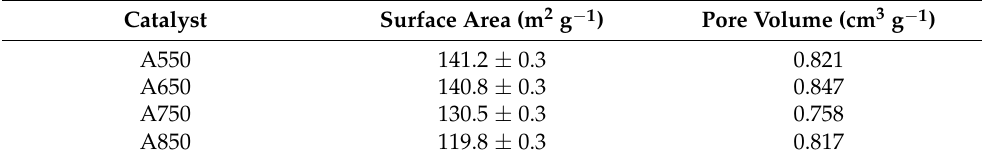
Table 2. Surface area and pore volume of each